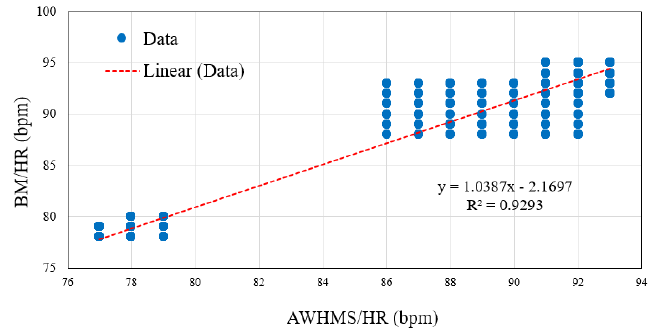
Figure 11. Correlation between AWHMS and BM HR data.